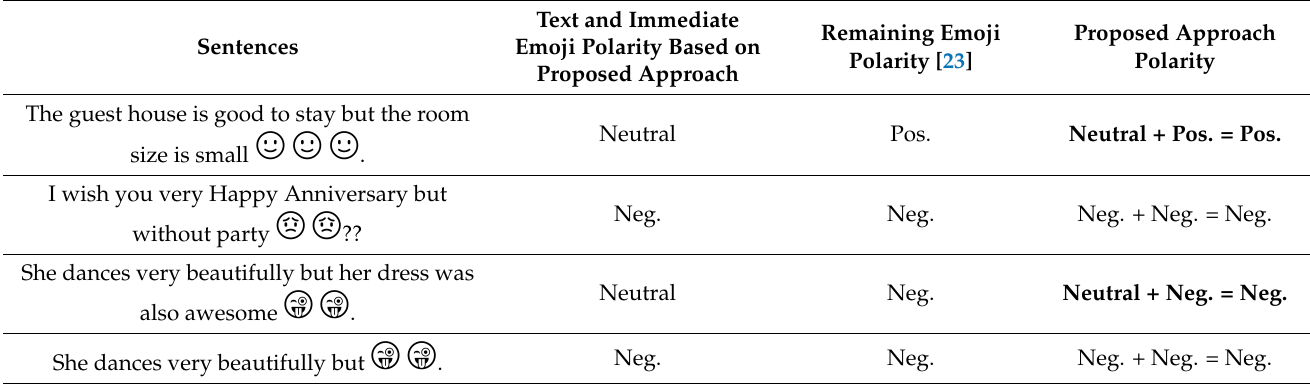
Table 6. The polarity of sentence based on the commonsense concept and context generated from proposed patterns of multiple emojis used in sentence.